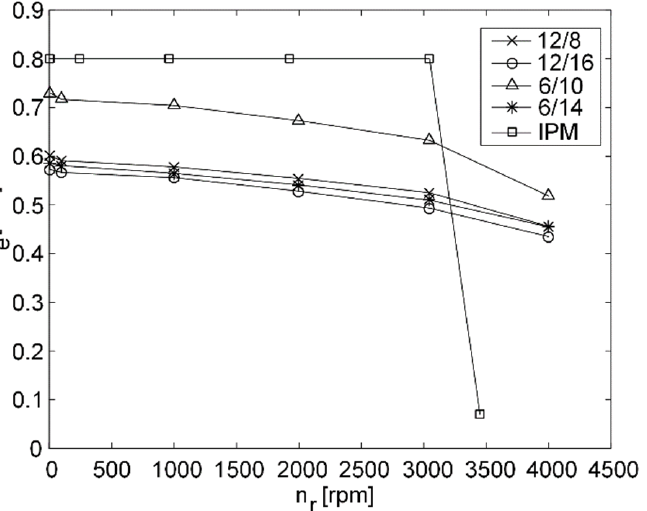
Figure 13. Torque-speed curves for all SRM configurations and the IPM at the nominal currents.